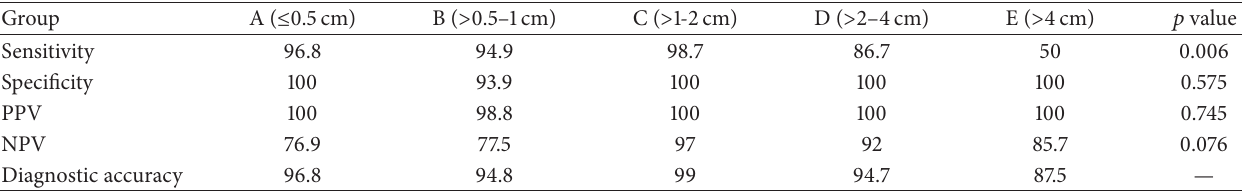
Table 3: Diagnostic indices of fine-needle aspiration cytology (FNAC) in the five thyroid nodule size categories. Group A ( ≤ 0.5 cm) B ( >